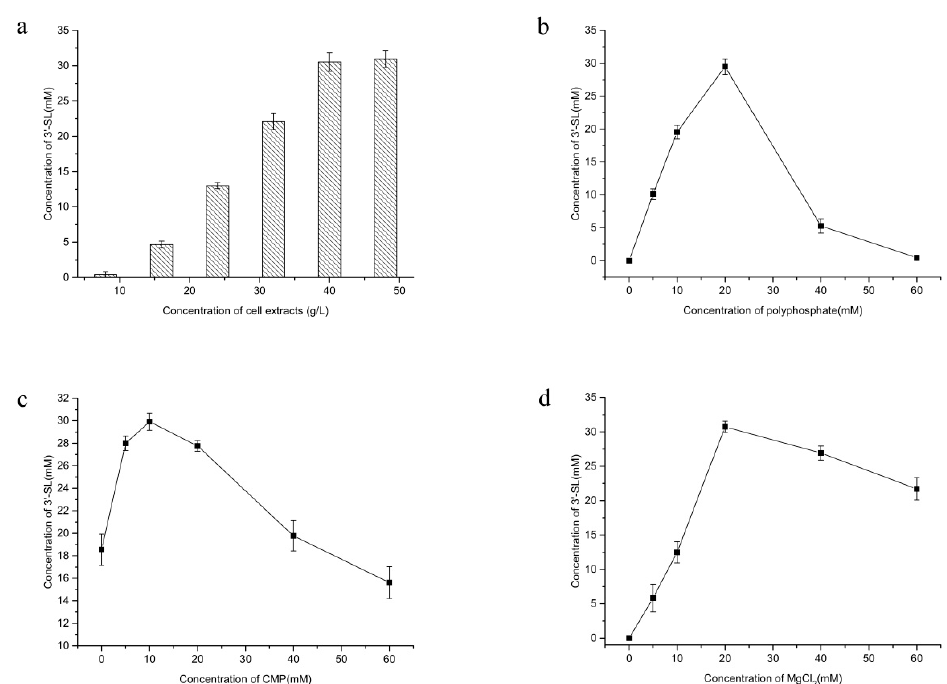
Figure 4. Effect of concentration of cell extracts ( a ), polyphosphate ( b ), CMP ( c ), and MgCl 2 ( d ) on 3 ′ -SL production.